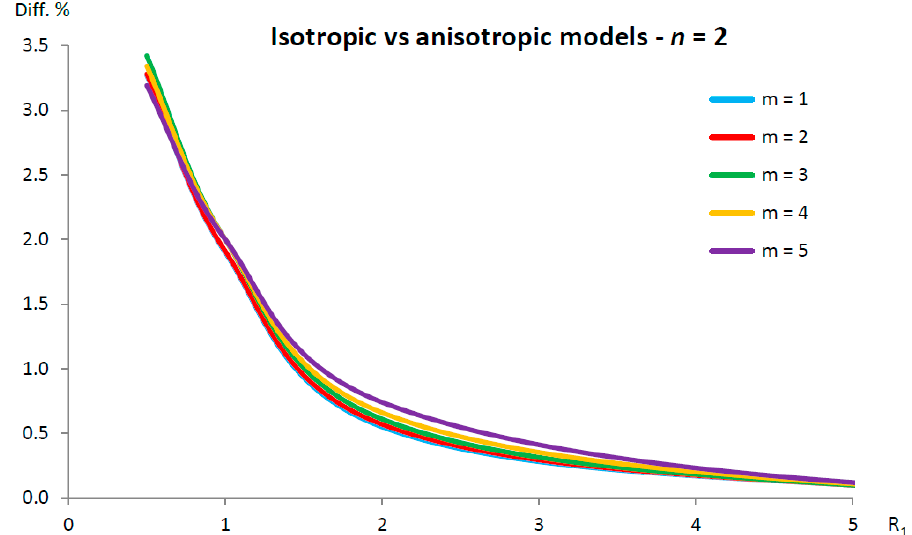
Figure 10. Percentage differences between the highest radial natural frequencies obtained via isotropic and anisotropic elastic shell models (anisotropic model as reference). Donnell shell theory. He’s formulation (39). Simply supported DWCNT of Tables 1 and 2 with aspect ratio L / R 2 = 10 and n = 2. Inner radius R 1 . Number of longitudinal half-waves m.